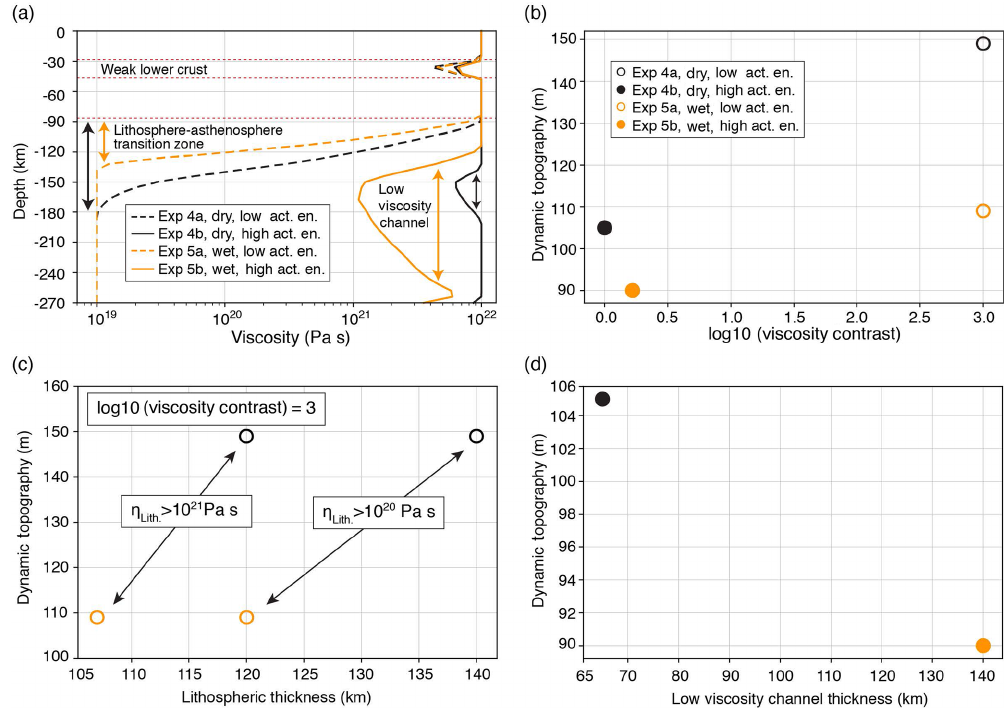
Figure 7. Factors affecting the dynamic topography. (a) Vertical viscosity profiles at the centre of the models. Variation in dynamic topogra- phy (b) by viscosity contrast between the lithosphere and part of the asthenosphere above the anomaly, (c) by lithospheric thickness (d) and by thickness of low-viscosity